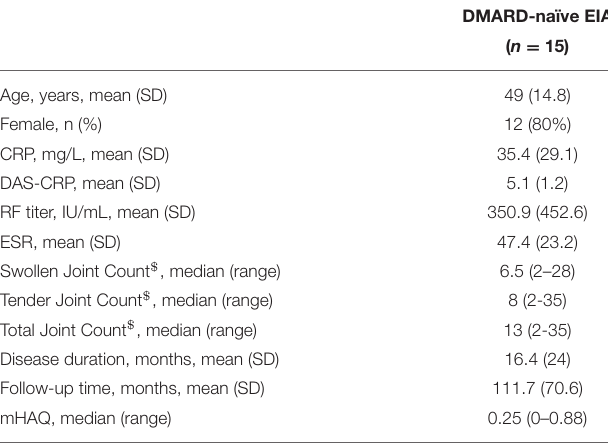
TABLE 1 | Baseline characteristics of DMARD-naïve EIA patients: All values are either reported as mean (standard deviation, SD), n (%) or median (range), as